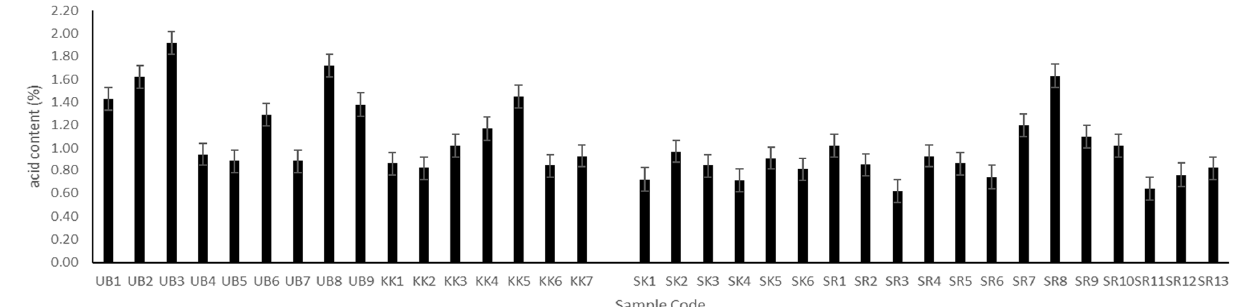
Figure 3. Acid content of Plaa-som samples from 4 provinces: Ubon Ratchathani (UB), Khon Kaen (KK), Sisaket (SK), and Surin (SR).